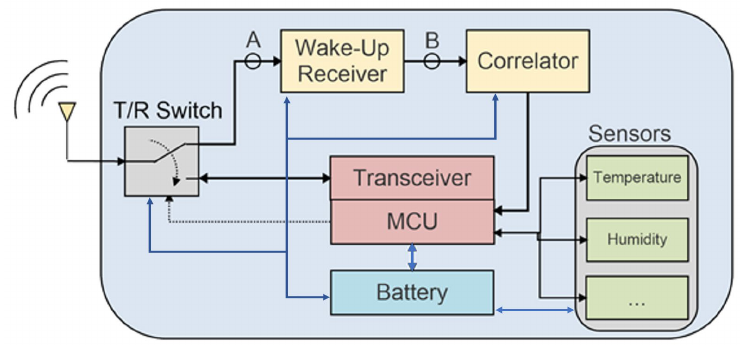
Figure 1. Block diagram of a sensor node integrating a WuR [3].